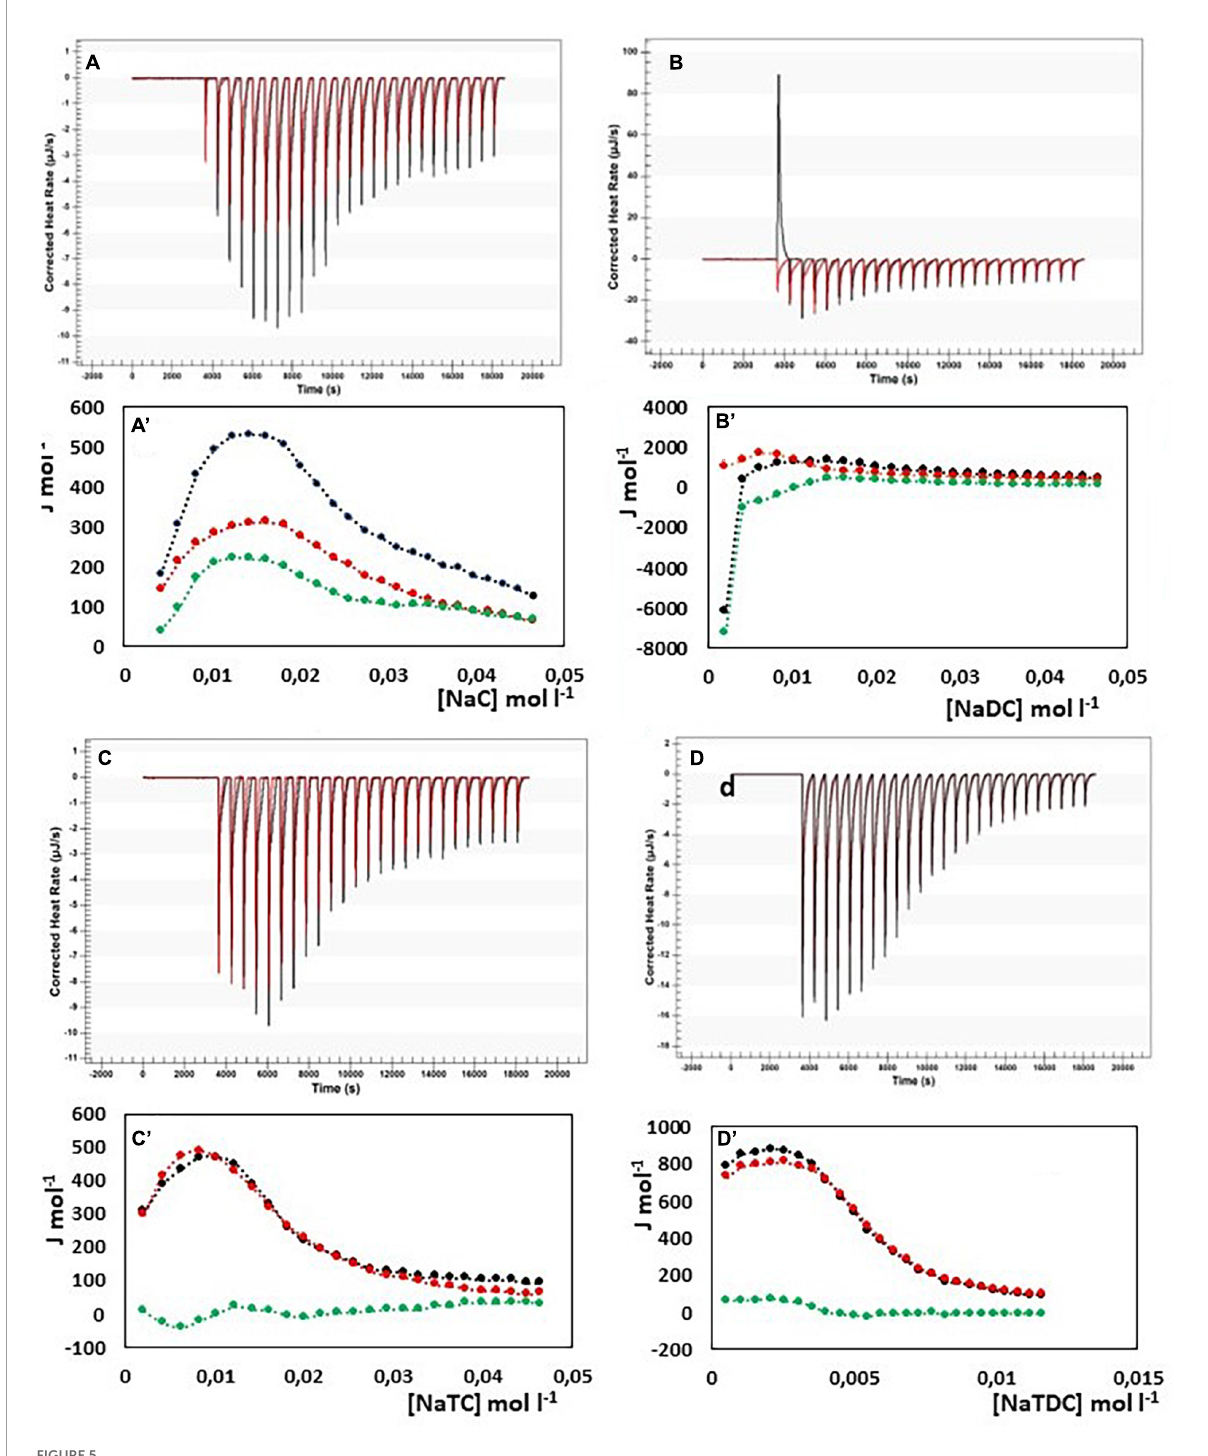
FIGURE5 Heat rate ( µ J s − 1 ) vs. time profiles obtained from 25 injection each of 10 µ L into a 960 µ L reaction cell filled with a pectin solution 1 g L − 1 (black) compared with the dilution of bile salt (red) in the same conditions, and (specified by a single quote mark) the dependence of the enthalpy change vs. bile salt concentration in the reaction cell for: (A) NaC 200 mM; (B) NaDC 200 mM; (C) NaTC 200 mM; (D) NaTDC 50 mM. Black dots represent the interaction enthalpy between pectin and bile salt, the red dots the dilution enthalpies of bile salt and the green dots their